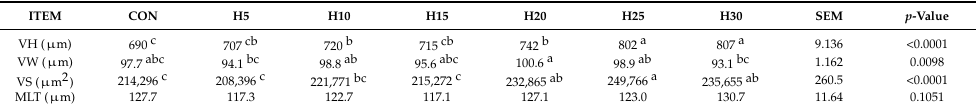
Table 4. Intestinal histomorphology assessment in Siberian sturgeons fed experimental diets contain- ing increasing shares of black soldier fly full-fat larvae meal.